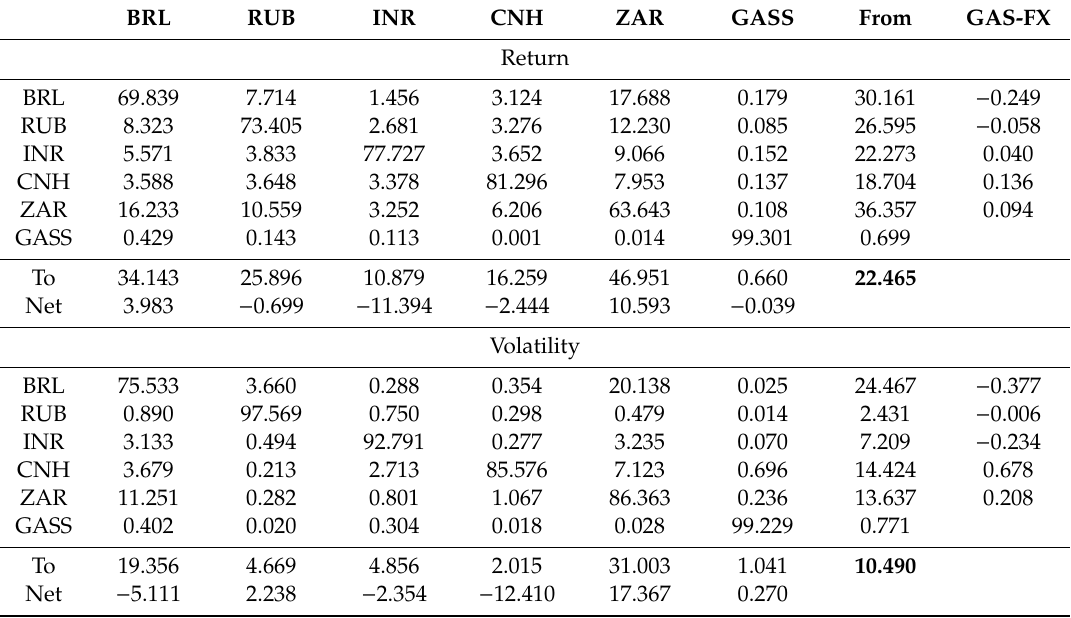
Table A1. Connectedness between the natural gas spot price and BRICS’s exchange rates.